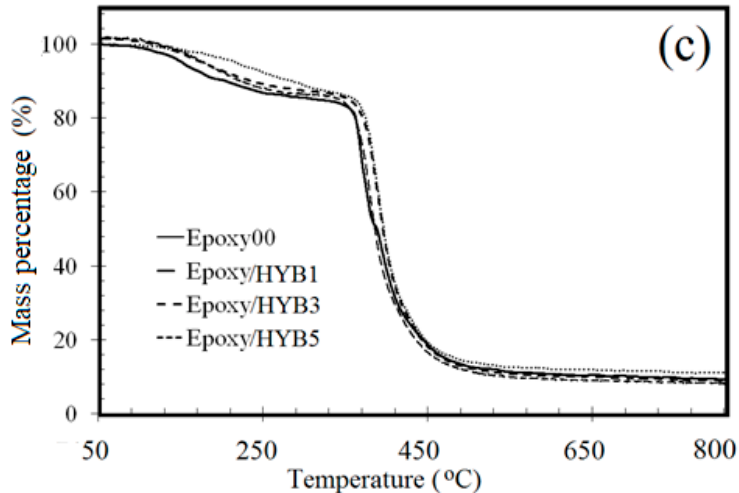
Figure 3. Comparison of mass residue for epoxy composites with different filler loading at ( a ) β = 5